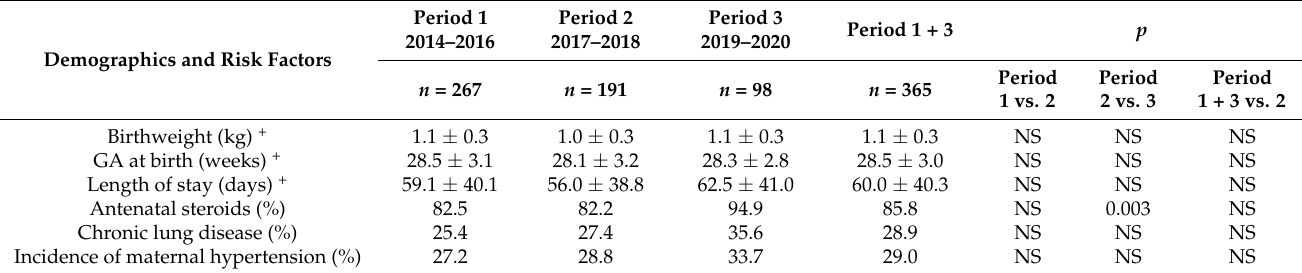
Table 4. Demographics and hypertension risk factors from unit-specific registry data in all VLBW infants.